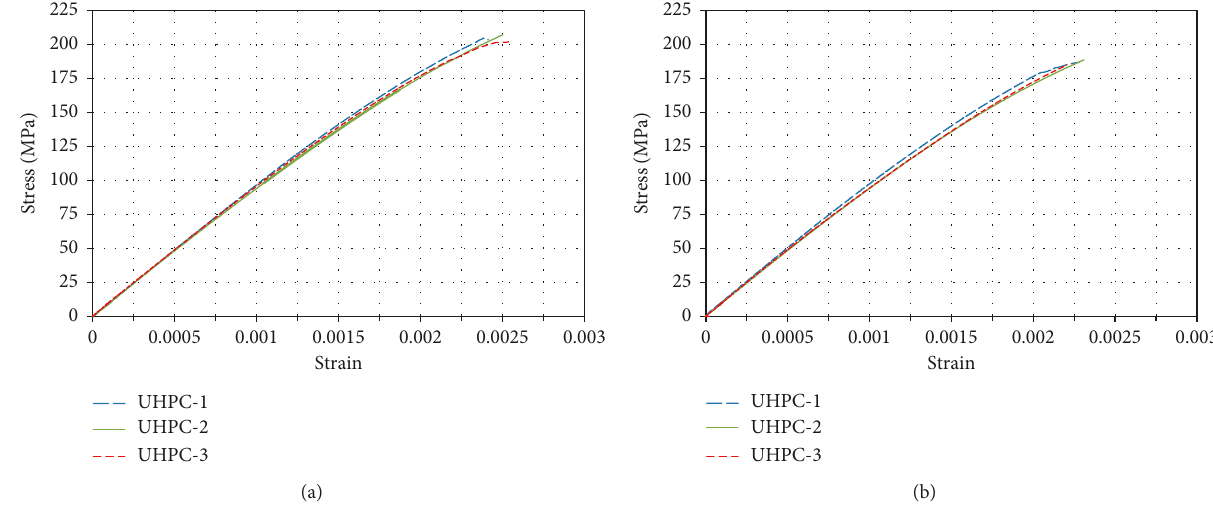
Figure 9: Stress-strain curves of UHPC: (a) first pouring part; (b) second pouring part. Table 5: Measured compressive strengths for the